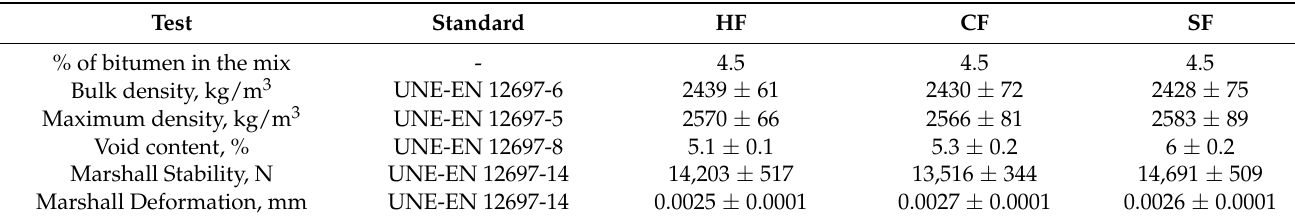
Table 6. Physical and mechanical properties of the HF, CF and SF families of bituminous mixtures blended with the optimum combination of